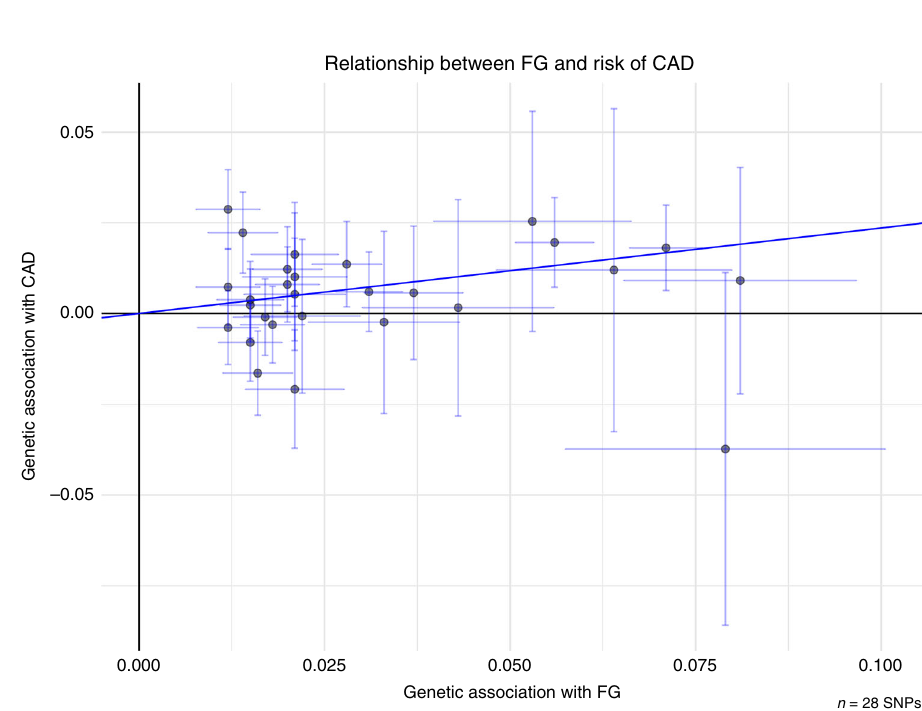
Two-sample MR results of the association between genetically determined HbA1c levels and CAD using robust IVW.